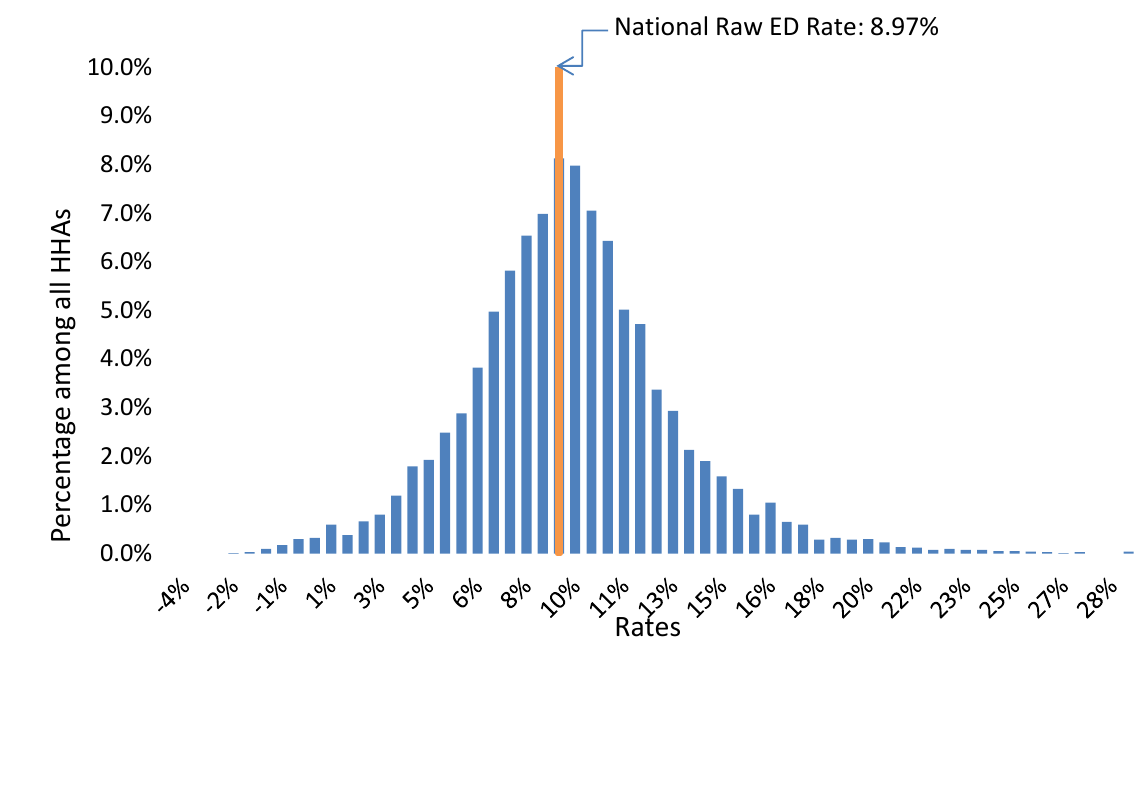
R EPORT TO C ONGRESS : S OCIAL R ISK F ACTORS AND P ERFORMANCE U NDER M EDICARE ’ S V ALUE -B ASED P URCHASING P ROGRAMS